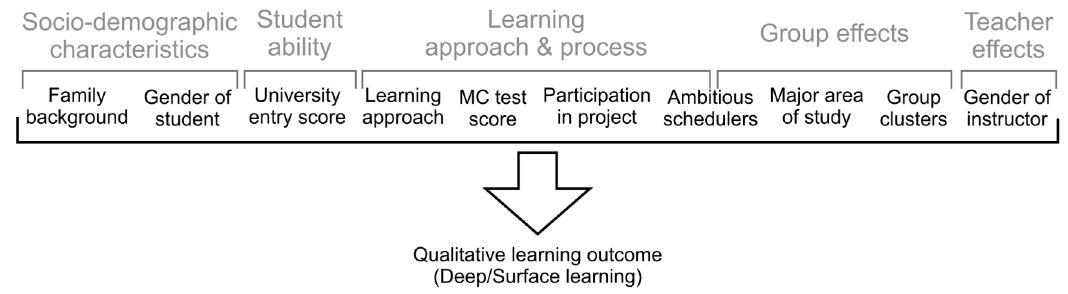
Figure 3. Variables of the research (in black). Corresponding concepts are indicated in gray.